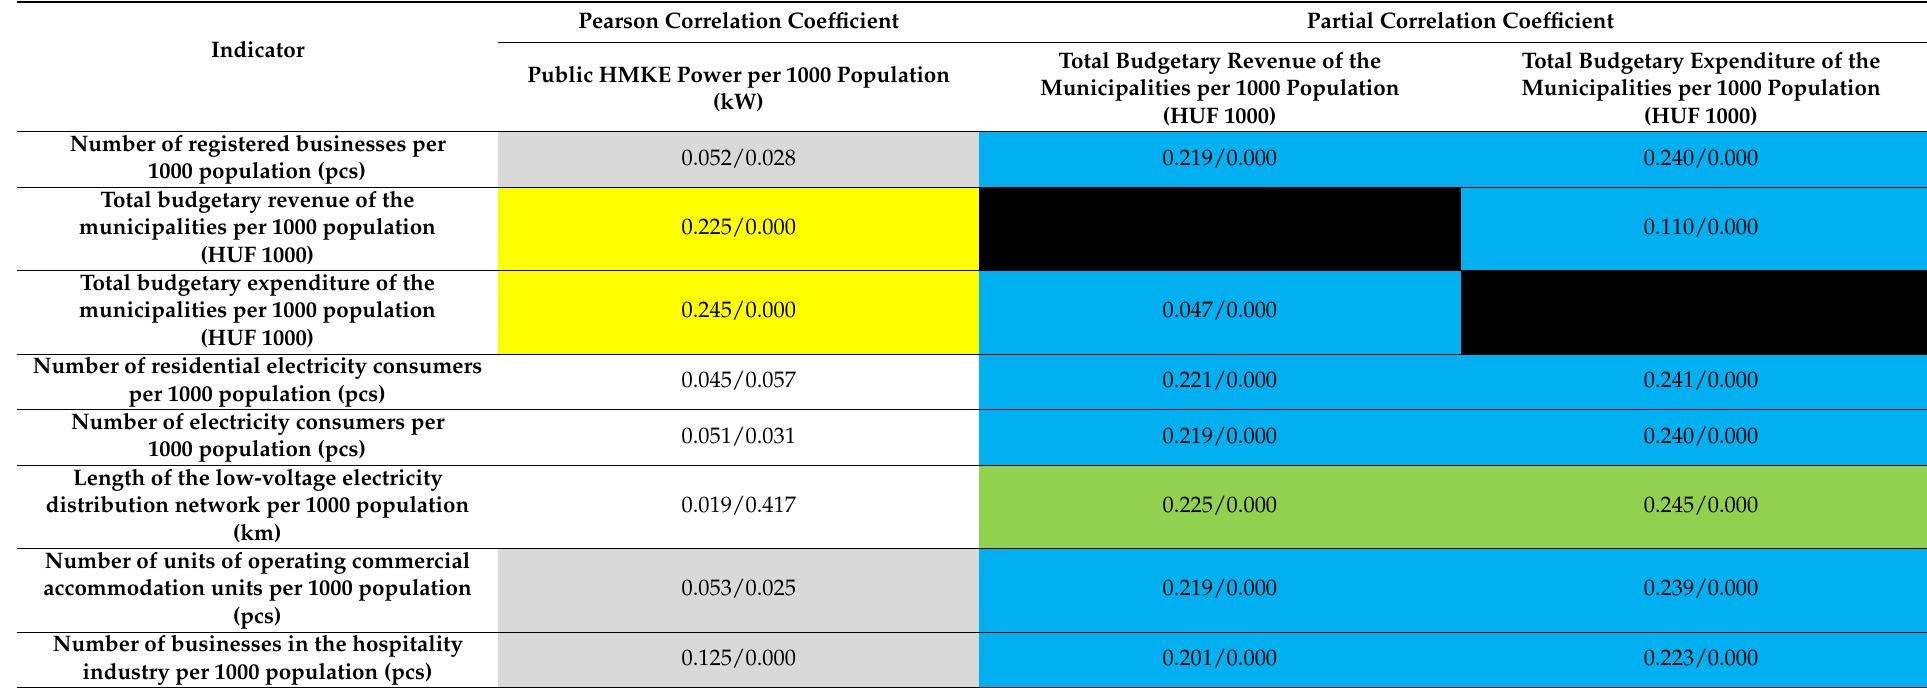
Table A8. The strengths of the relationships between the power of the public HMKEs per 1000 population and the settlement indicatorsv 1 ( 1 Pearson correlation coefficient/ p -value; if p < 0.05, then there is a significant verified relationship between the two variables) (In the case of the Pearson correlation coefficients in the table white background indicates non–significant relationships, grey weak and yellow means weak moderate ones. In the case of the partial correlation the green background signals cases where the background variable did not cause any difference in the strength of the relationship, while blue background indicates partial explanation (the controlled variable explains the relationship between variables i and j only partially), and black marking shows irrelevant